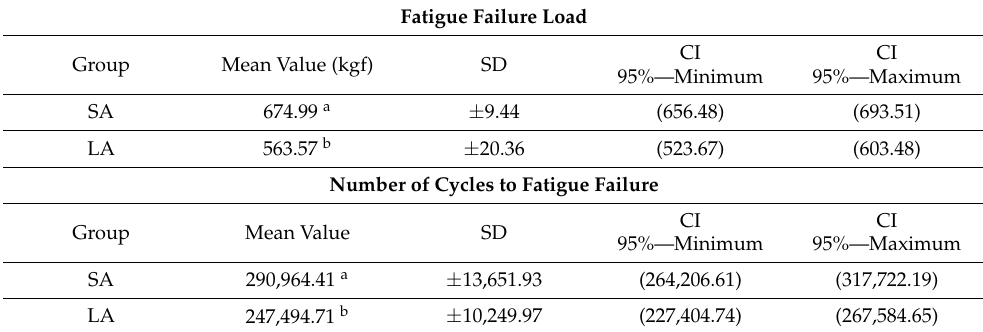
Table 3. Mean value ± standard deviation (SD) of the data obtained by resistance in the analysis of maximum load for fracture for the titanium implant group with long PEEK abutment and group.